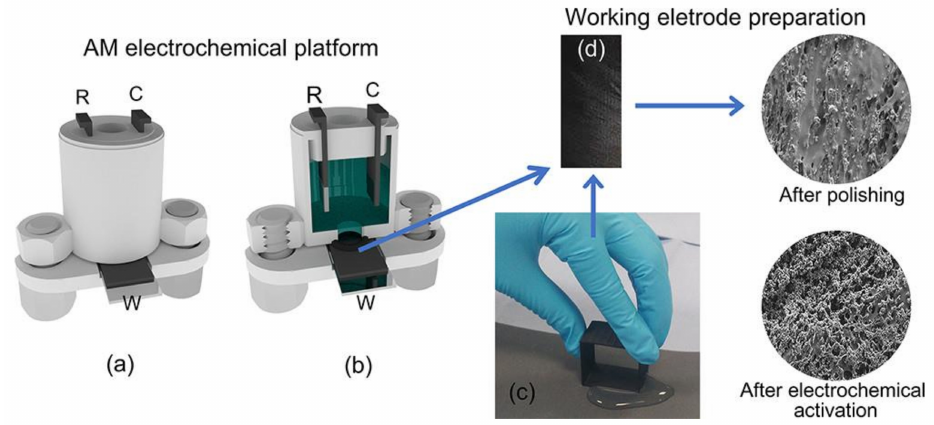
Figure 16. Schematic diagrams of the AM electrochemical platform and the 3D printing working electrode preparation procedure: ( a ) complete AM electrochemical platform, ( b ) transversal cut view of the AM electrochemical platform (total volume = 5 mL), ( c ) polishing procedure of the hollow printed cube (3.0 × 3.0 × 1.5 cm 3 and thickness of 0.75 mm), ( d ) rectangular printed base after polishing (3.0 × 1.5 cm 2 and thickness of 0.70 mm). Other information: (R) 3D-printed pseudo-reference electrode, (C) 3D-printed counter electrode, (W) 3D-printed working electrode. SEM images of the polishing 3D-printed working electrode before and after electrochemical activation are also shown (Reproduced with permission from Reference [153], copyright 2019, American Chemical